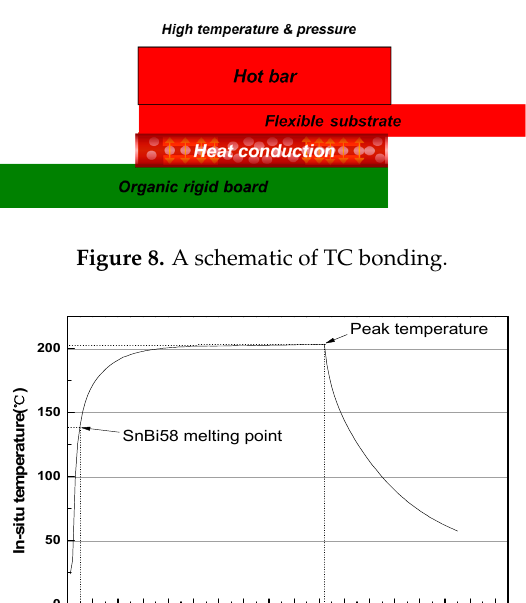
Figure 9. The in-situ temperature profile of solder ACFs joint by a TC bonding.